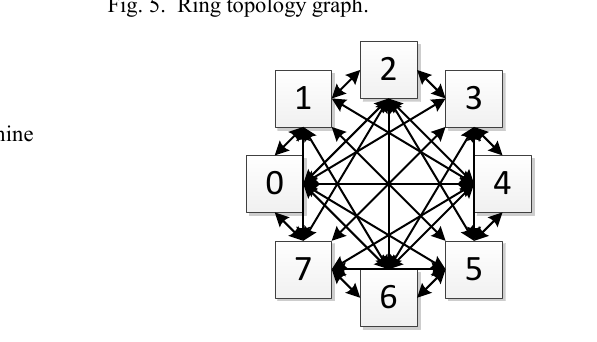
Fig. 5. Ring topology